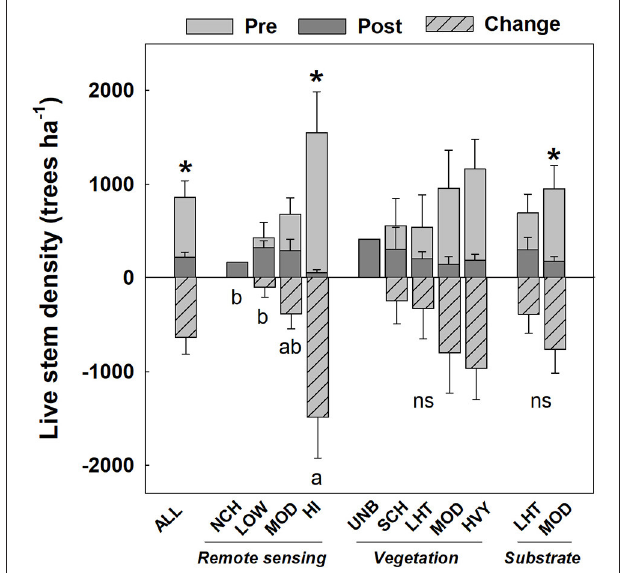
FIGURE 3 | Mean ( ± s.e.) number of live trees ha − 1 measured pre-fire and post-fire in burned plots, shown for overall severity levels (ALL) and for plots classified by three burn severity classification systems. Fire severity classifications determined from remote sensing includes unchanged (NCH), low (LOW), moderate (MOD), and high (HI) severity. Vegetation and substrate severity follows National Park Service classification scheme, including unburned (UNB), scorched (SCH), lightly burned (LHT), moderately burned (MOD), and heavily burned (HVY). Difference bars below the zero line indicate the number of tree stems killed by the fires used in this study. Asterisks (*) indicate significant differences between pre- and post-fire measurements, within severity level. Lowercase letters below the zero line indicate significant differences in the change between pre- and post-fire measurements (hatched bars) among severity levels within classification system; ns indicates no significant differences ( p < 0.05). Differences among severity levels for pre-fire and for post-fire measurements are described in the text. All plots used in this study were burned by wildfire, including those classified into the unchanged or unburned severity